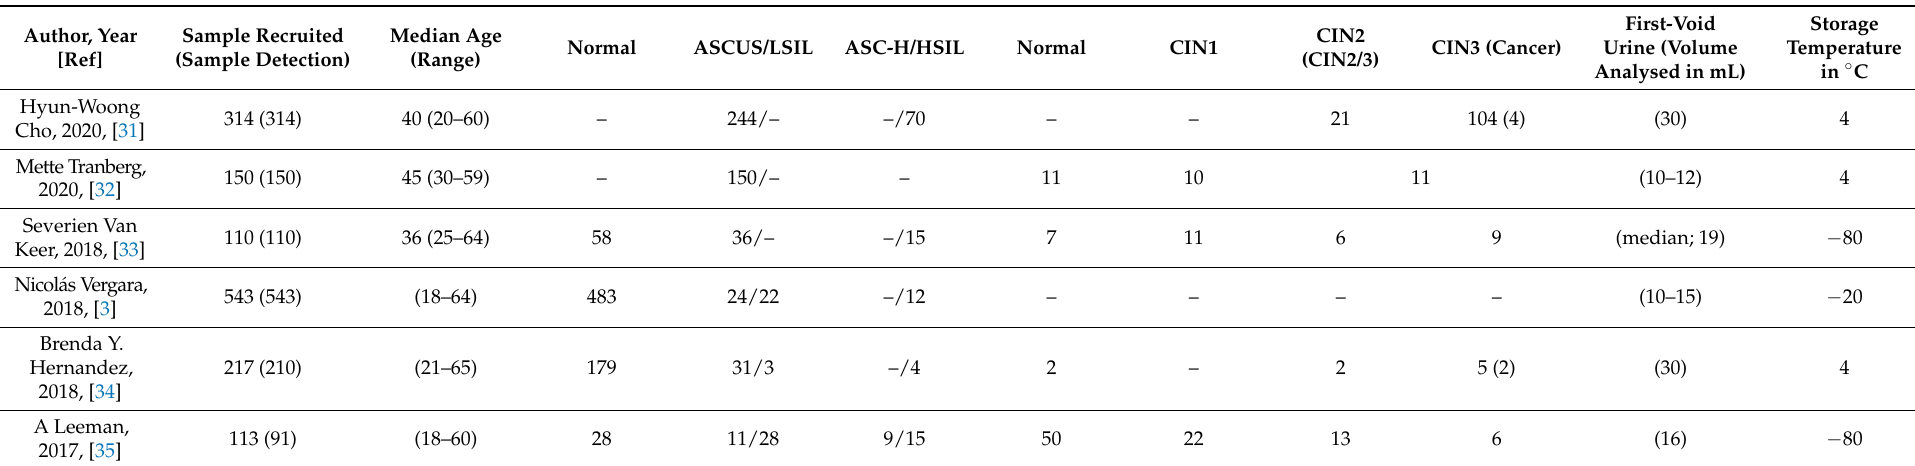
Table 2. Quantitative characteristics of included